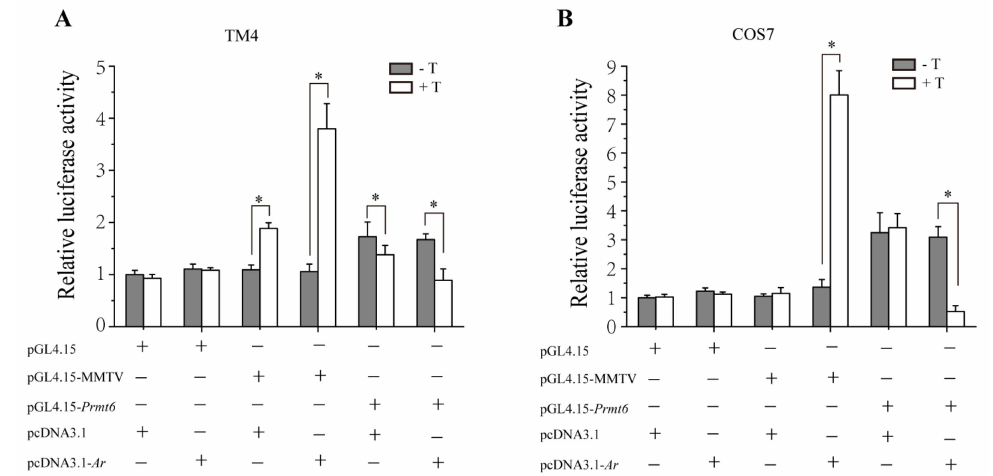
Figure 4. Inhibition of Prmt6 promoter activity by AR along with testosterone treatment in TM4 and COS7 cells. ( A , B ) TM4 and COS7 cells were transiently cotransfected with 200 ng of pGL4.15 (which has a firefly luciferase reporter gene) or pGL4.15-MMTV (mouse mammary tumor virus long terminal repeat, which was a hormone responsive promoter and located in the upstream of the luciferase reporter gene) or pGL4.15- Prmt6 (containing the promoter region of Prmt6 ), 200 ng of pcDNA3.1 (empty vector) or pcDNA3.1- Ar (over-expression of Ar , containing the coding sequence of Ar ) and treated with or without testosterone (T, 10 nM). The relative luciferase activity was calculated from firefly luciferase data standardized to renilla luciferase data. All the experiments were performed in triplicate and repeated at least three times. Data are expressed as the mean ˘ SD. * p <